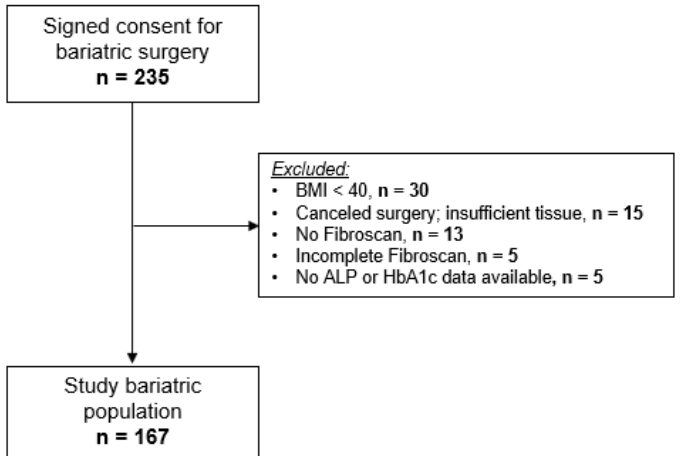
Figure 1. Flowchart of the patient population. Their mean age at the time of bariatric surgery was 46.4 years (range: 22.9–77.2 years), and the majority (83.2%) was female. Histologically, the prevalence of steatosis alone was 29.3% (49/167). Furthermore, the prevalence of steatohepatitis (with or without fibrosis) was 40.7% (68/167). Lastly, the prevalence of F ≥ 2, F3, and F4 was 11.4%, 5.4%, and 1.8%, respec- tively. Additional clinical and laboratory data are shown in Tables 1 and 2, respectively. Table 1. Demographic and clinical features of the enrollee subjects who underwent bariatric surgery at our institution between July 2017 and November 2019 ( n = 167).